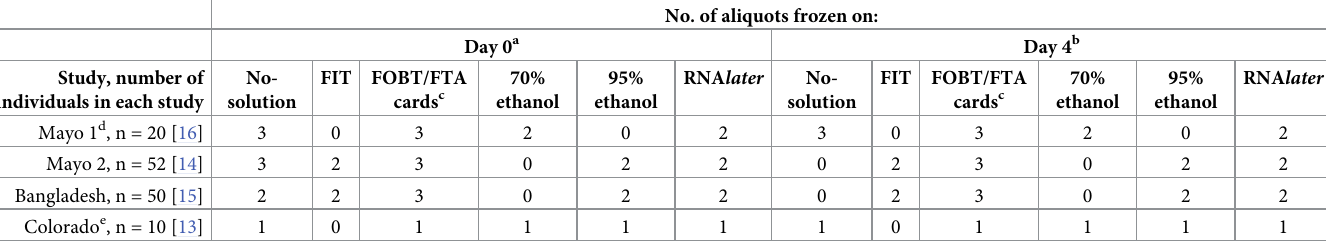
Table 1. Number of replicate samples per participant by fecal collection method and day of freezing in the meta-analyses of pooled samples from five studies (Mayo 1-Knight lab, Mayo 1-Mayo lab, Mayo 2, Bangladesh, and